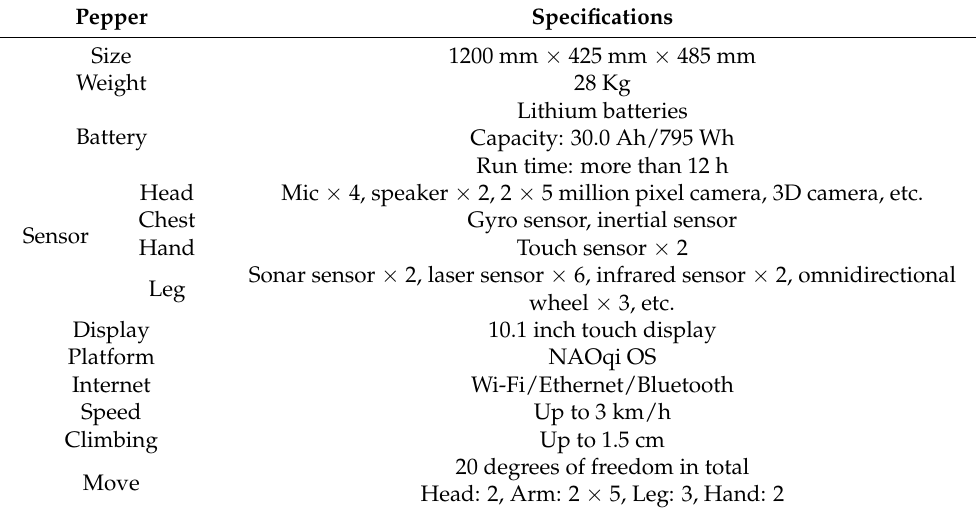
Table 2. Main specification parameters of Pepper.